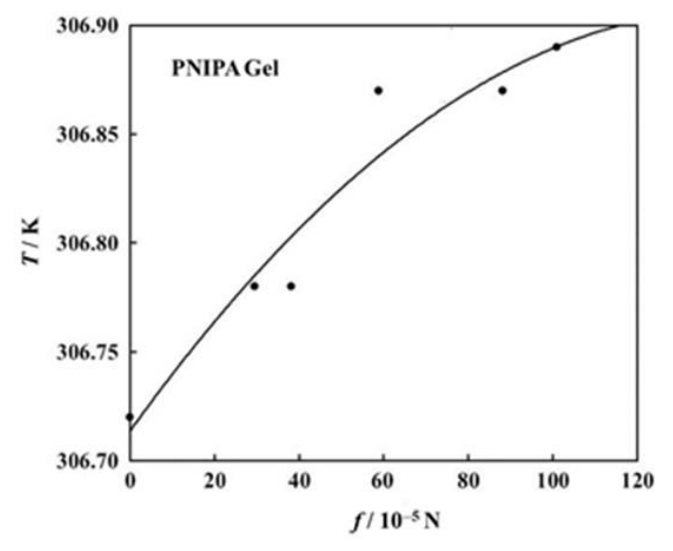
Figure 9. Force dependence of transition temperature for the PNIPA gel [40].